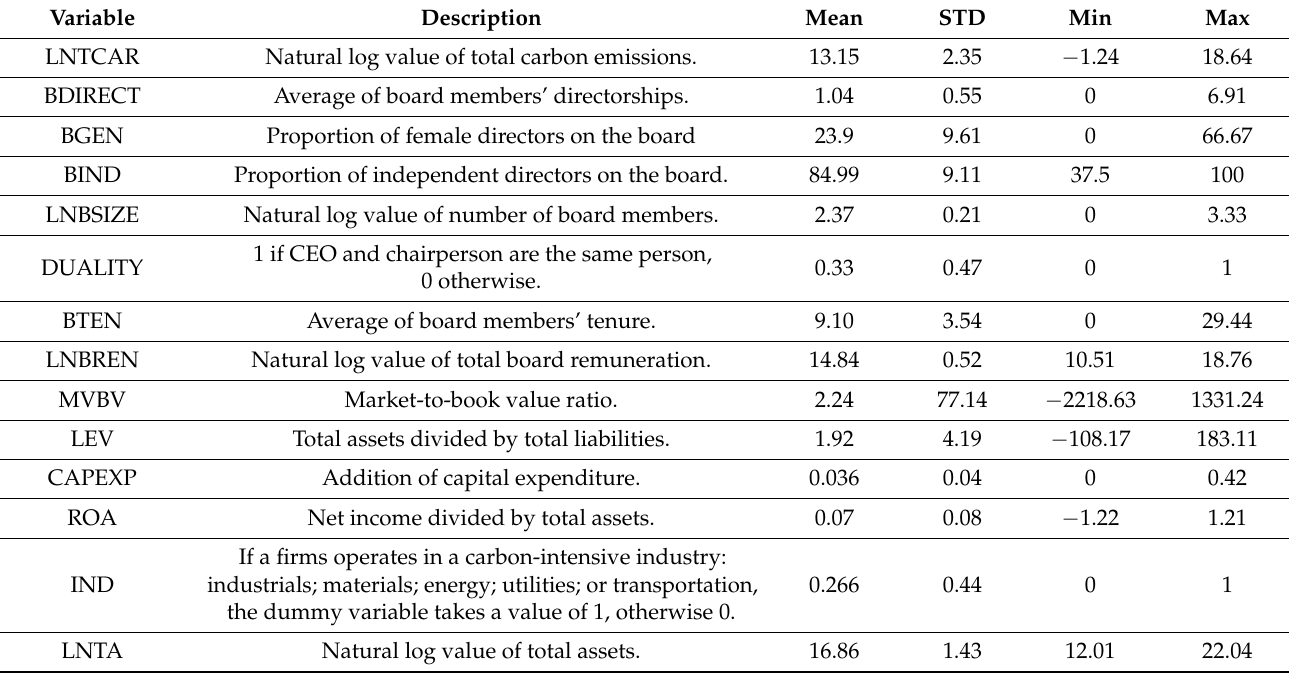
Table 1. Descriptive